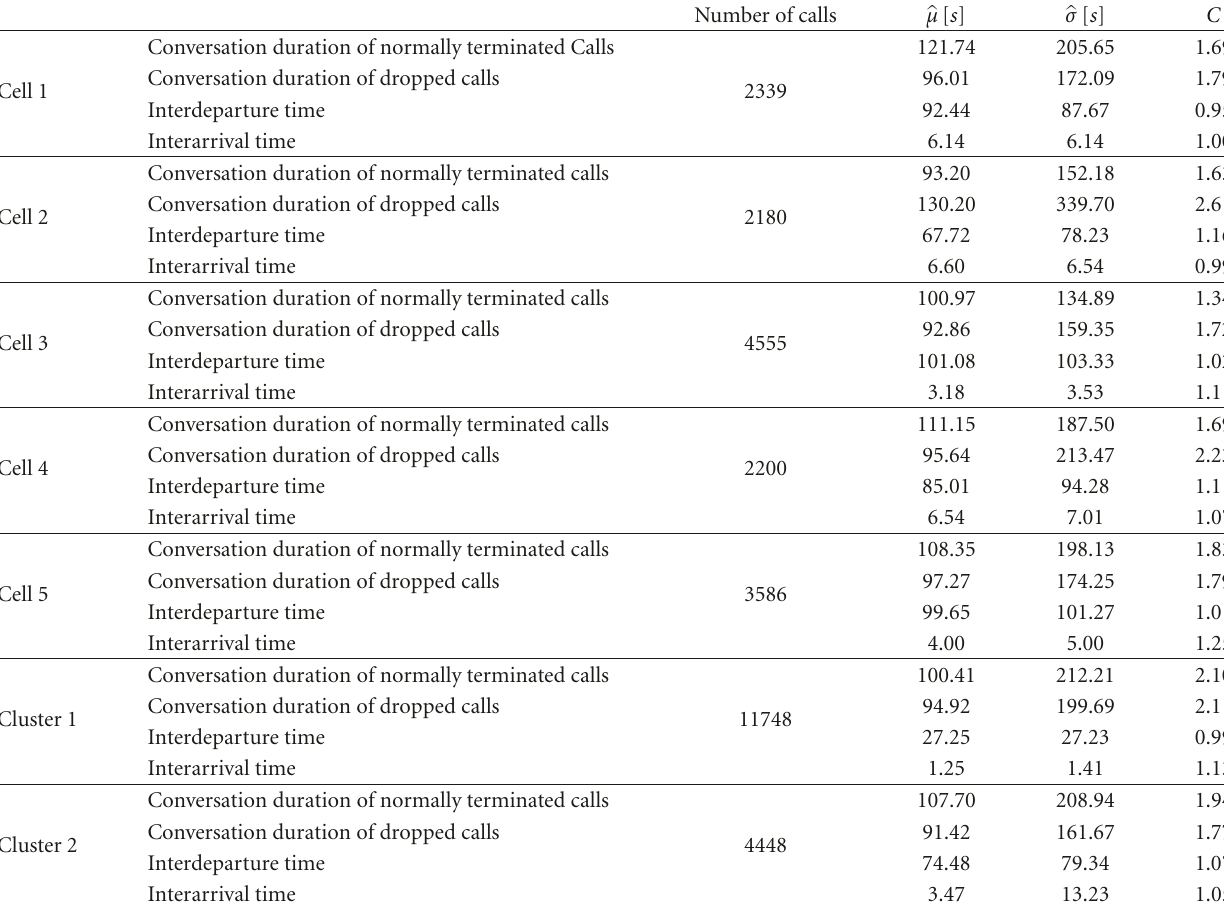
Table 2: Estimated statistical